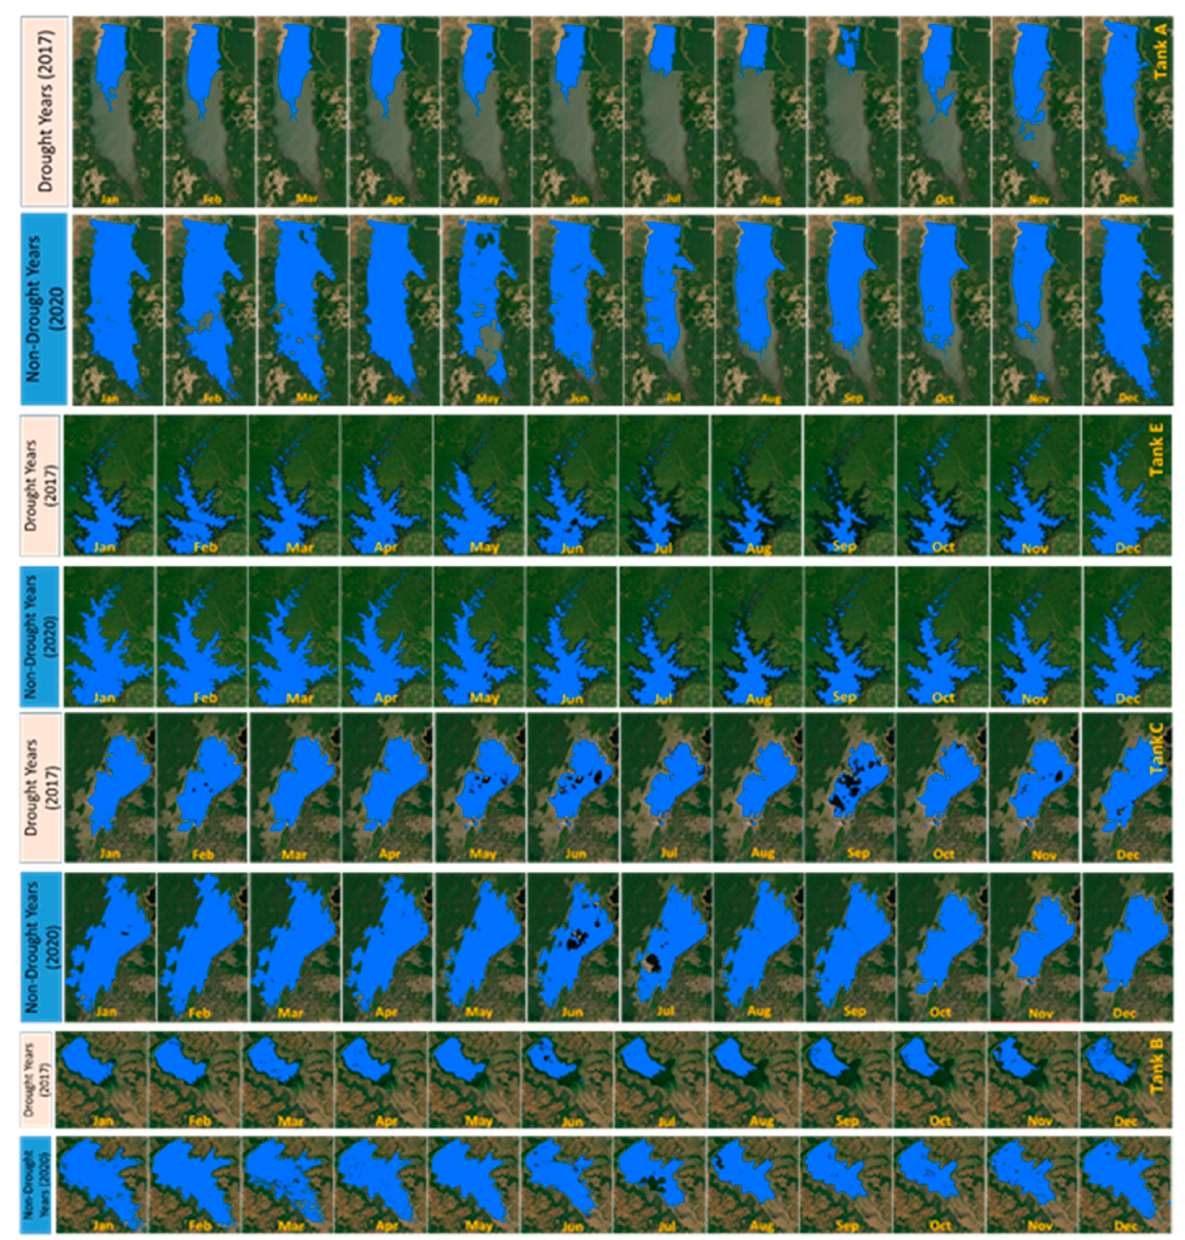
Figure 4. Spatial pattern of water monthly water dynamics in Tank A, Tank E, Tank C, and Tank B in drought year (2017) and wet year (2020). The water surface area of Tank A continued to be less than 30% of the maximum area from July to October 2016, with the lowest area of 20% being recorded in September. The specialty is that in 2019, the minimum water surface area was only 37%, and it was reported only in one month. In 2019 the surface water area was more than 80% for 7 months, and in 2016, only one month exceeded 80%; since January 2016, the surface water area has been gradually declining. Table 4 shows the numerical values of the monthly water surface area of Tank A and Tank